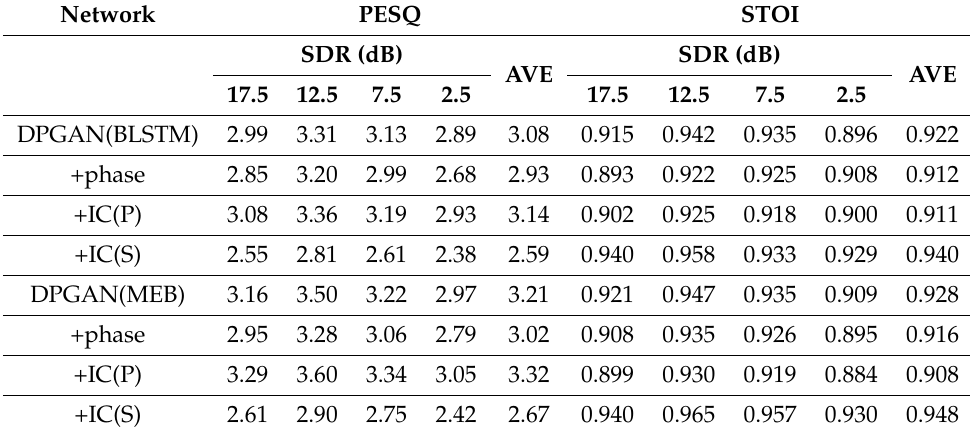
Table 3. Ablation